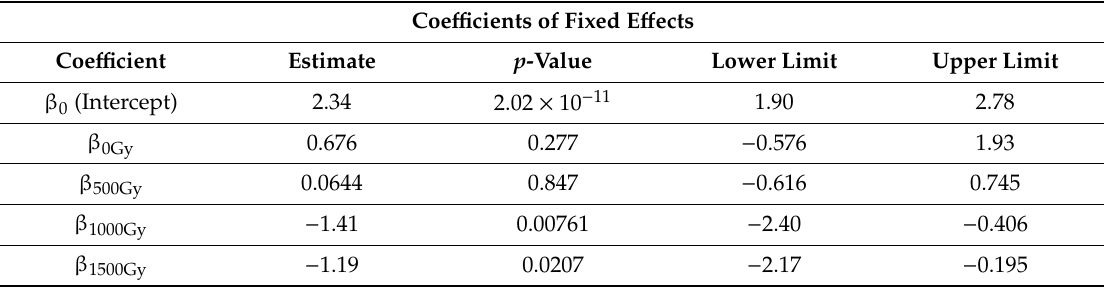
Table 2. Parameters calculated by linear mixed model (LMM) analysis to evaluate changes in activities of the irradiated body-wall muscle cells around the CNS between before and after targeted irradiation.